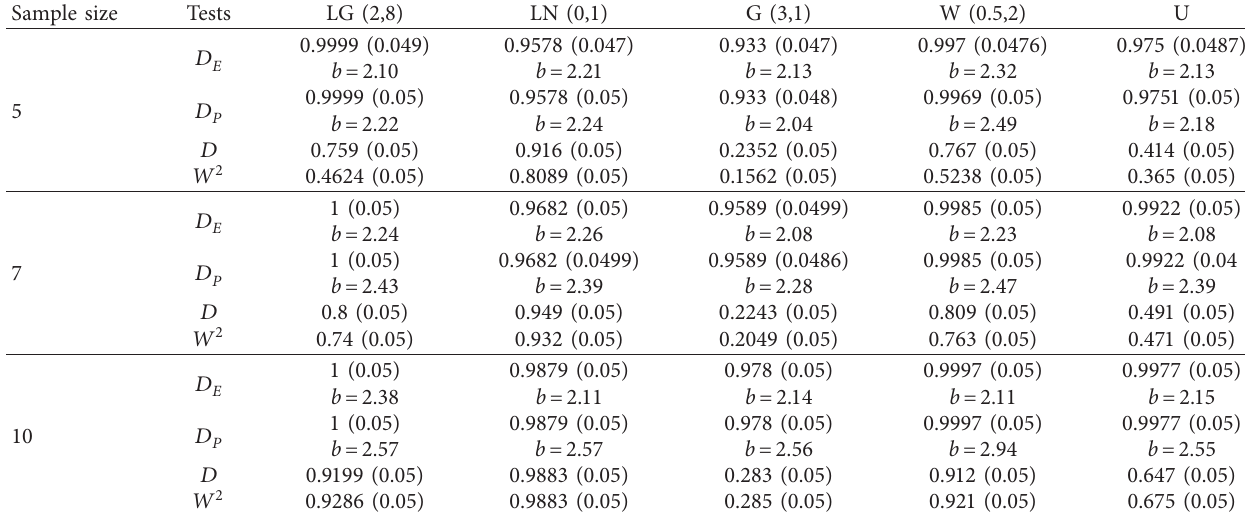
Table 2: Monte Carlo power estimates of the tests at 5 percent significant level with null distribution function Power (2,2). Sample